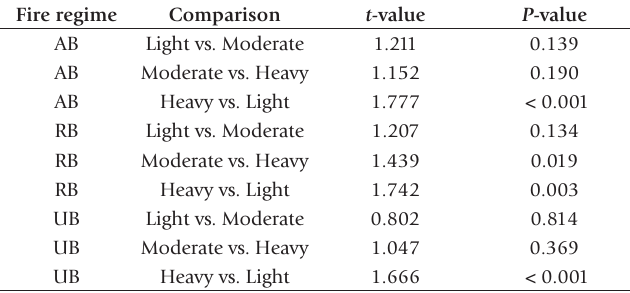
Grass cover Table 4. Grasshopper assemblage composition response to grazing intensity under different fire regimes. Pairwise comparisons among grazing intensity classes (light, moderate and heavy) for annually- burned (AB) firebreaks and grasslands with longer fire rotations (LFR) that were recently-burned (RB) (i.e. < 12 months prior to sampling) and unburned (UB) (i.e. burned >12 months prior to sampling). Fire